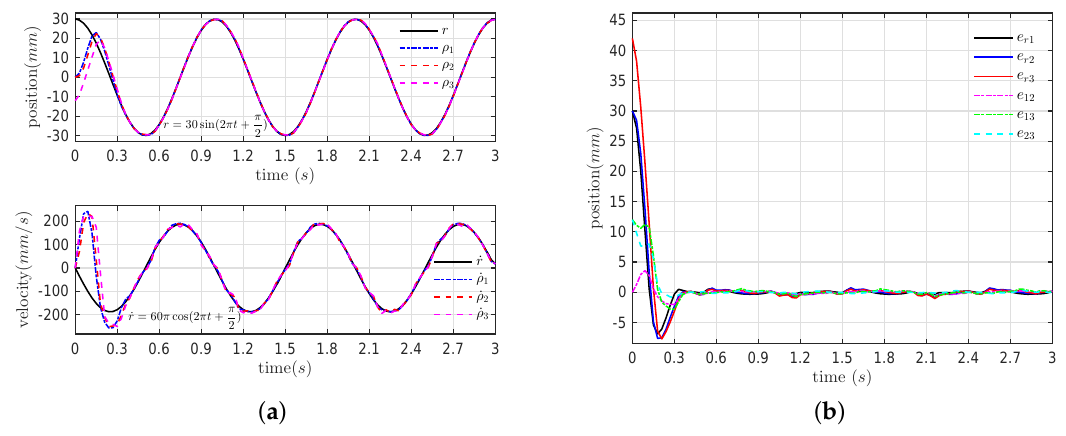
Figure 7. Position and velocity of reference and three LSRMs corresponding with Example